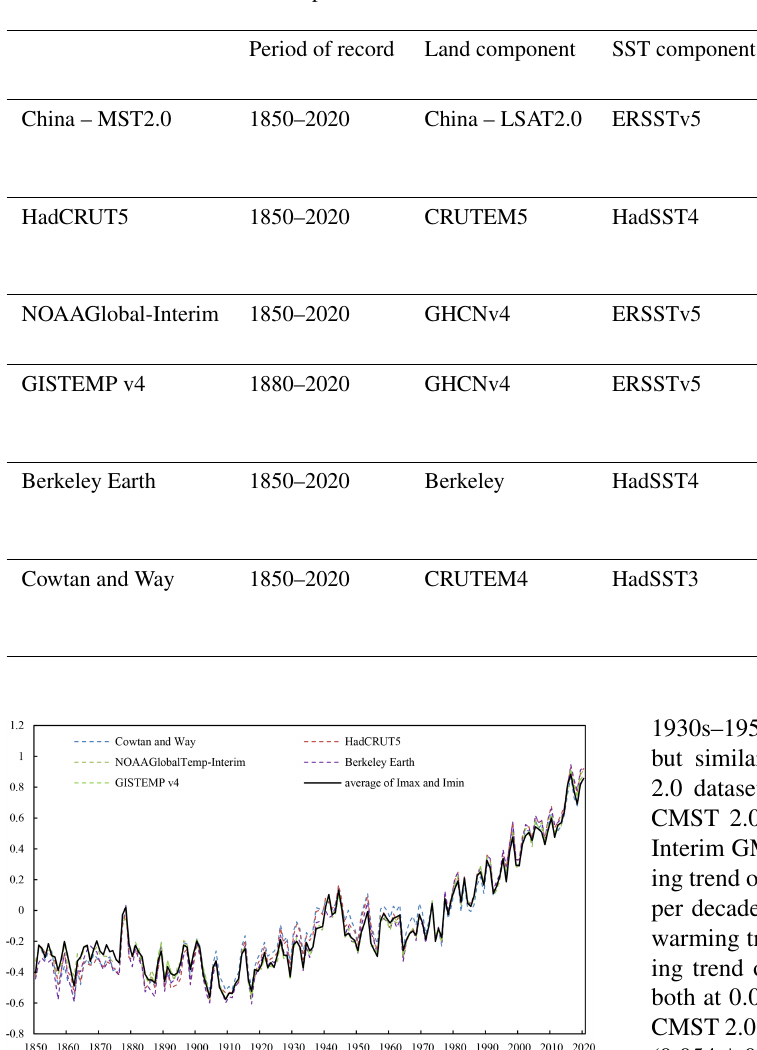
Table 3. General information of input datasets.